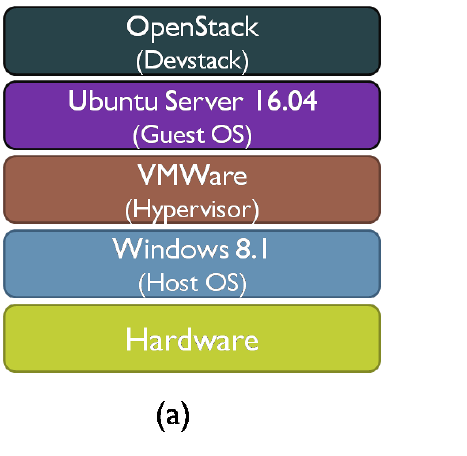
Figure 3. Scenario 1 configuration stack.